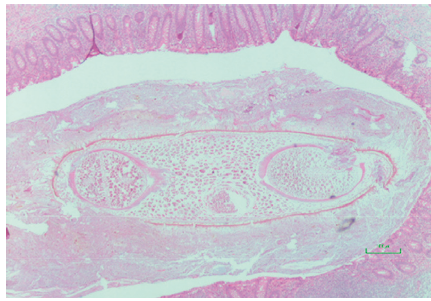
Figure 6: Appendix infested with B. coli .